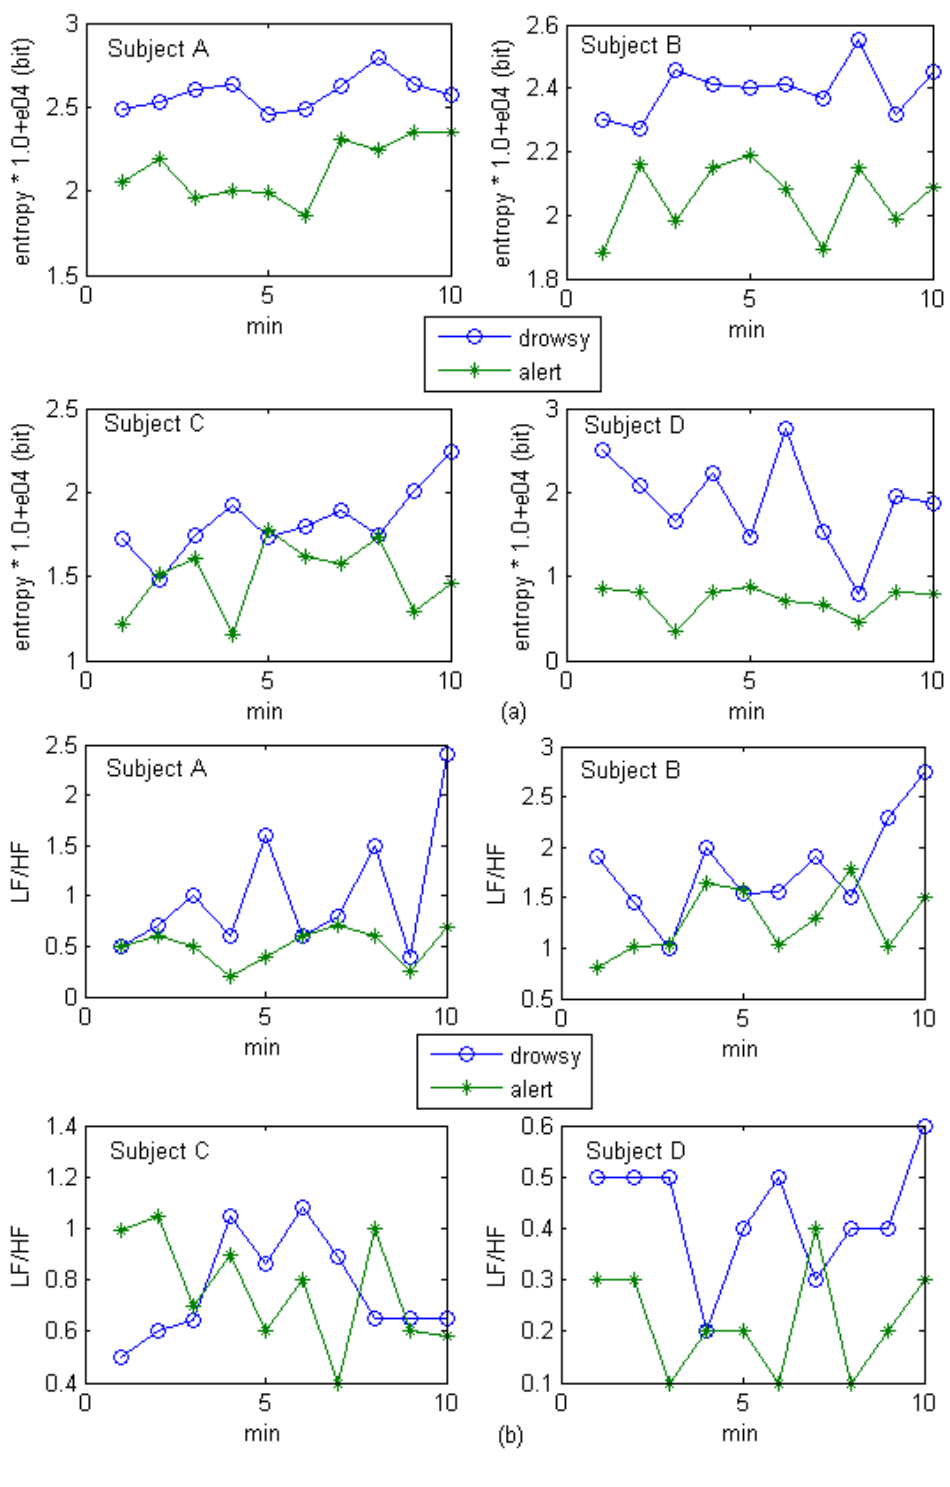
Figure 11. Entropy values of level A driving groups; ( a ) entropy values; ( b ) LF/HF